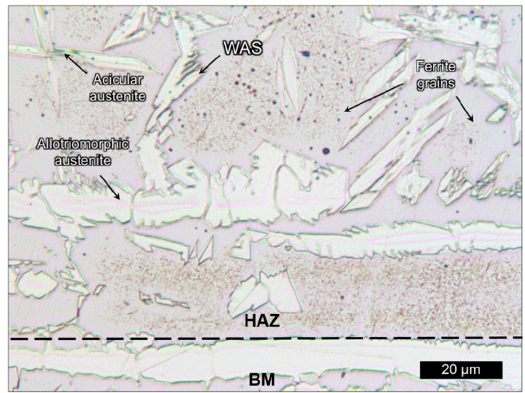
Figure 14. Microstructure in heat-affected zone. WAS—Widmanstätten austenite side-plate. The dashed black line represents the boundary between the HAZ and the unaffected BM.